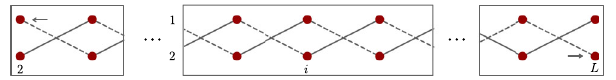
FIG. 2. Class BDI one-dimensional lattice model containing two competing hybridization processes indicated via solid and dashed lines. The model has a topological stationary state, whose winding number changes in a topological phase transition at the degeneracy point of equal hybridization